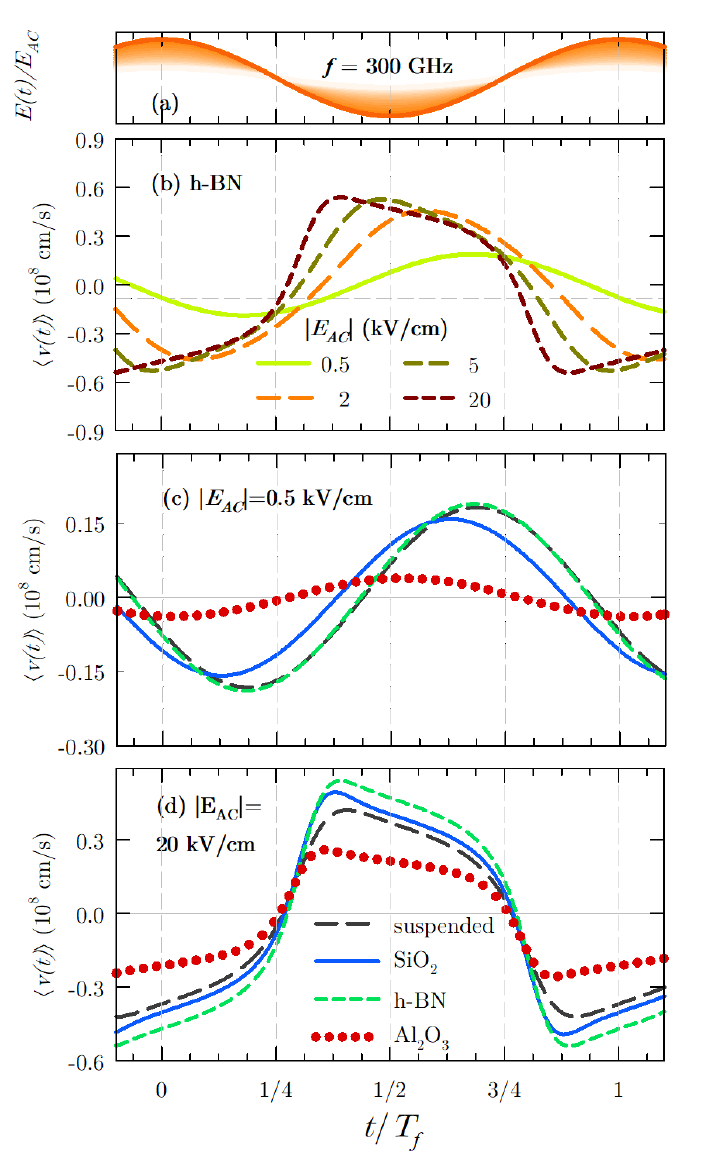
Figure 3. ( a ) Reference of the applied electric field. ( b ) Global velocity response of the system, (cid:104) v ( t ) (cid:105) for fields of 0.5,2,5 and 20 kV/cm for graphene over h-BN. ( c ) Comparison of the response for the graphene samples under study (on three substrates and suspended) with E AC = 0.5 kV/cm and ( d ) with E AC = 20 kV/cm. The excitation frequency is f = 300